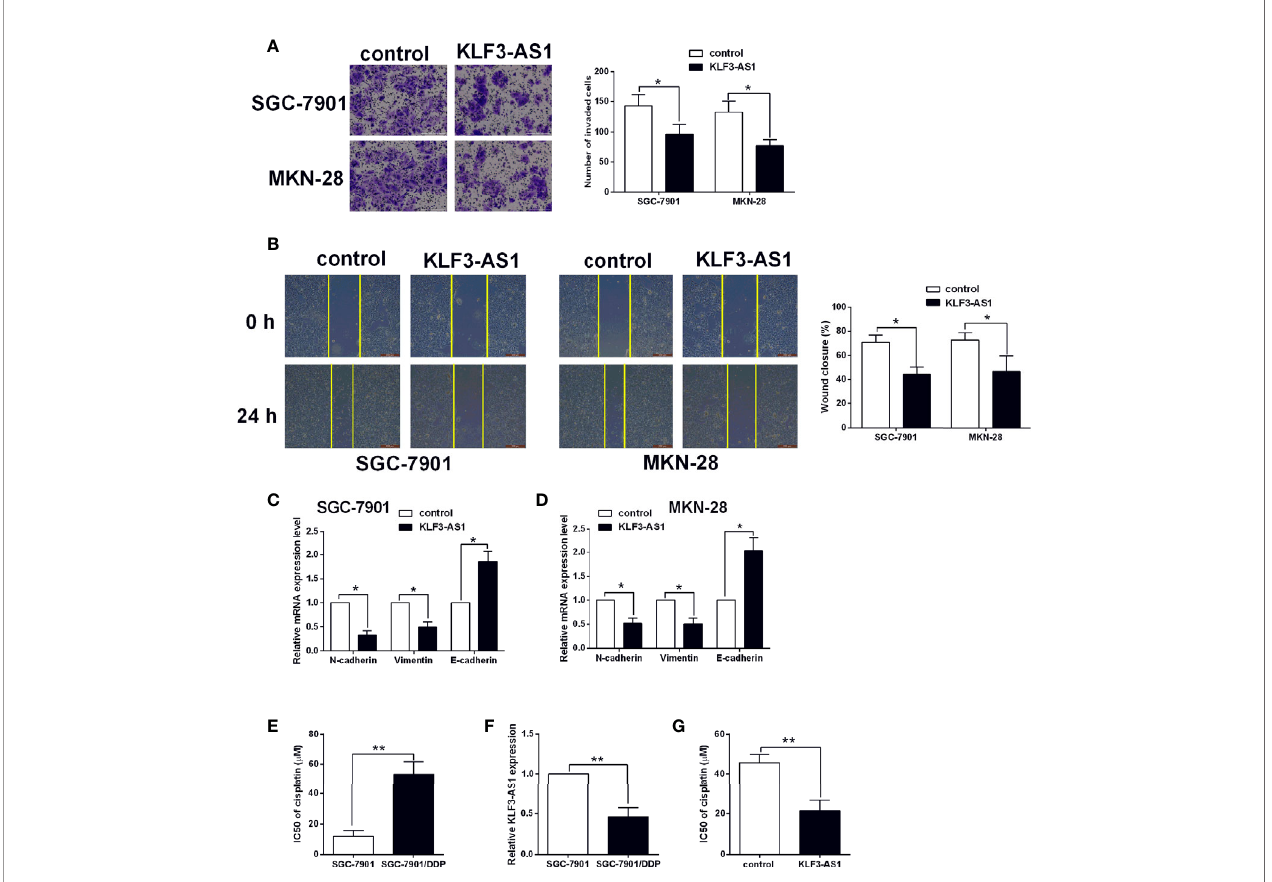
FIGURE 2 | KLF3-AS1 overexpression suppressed gastric cancer cell invasion, migration and EMT, but promoted chemosensitivity to cisplatin. The gastric cancer cells including SGC-7901 and MKN-28 were transfected with pcDNA3.1 (control group) or pcDNA3.1-KLF3-AS1 (KLF3-AS1), and at 24 h after transfection, (A) cell invasion of SGC-7901 and MKN-28 cells was determined by Transwell invasion assay; (B) cell migration of SGC-7901 and MKN-28 cells was determined by wound healing assay; (C, D) the mRNA expression levels of N-cadherin, vimentin and E-cadherin in SGC-7901 and MKN-28 cells were determined by qRT-PCR; (E) The IC50 values of cisplatin in SGC-7901 and SGC-7901/DDP cells were determined by CCK-8 assay. (F) KLF3-AS1 expression level in SGC-7901 and SGC-7901/DDP cells was determined by qRT-PCR. (G) The IC50 values of cisplatin SGC-7901/DDP cells transfected with pcDNA3.1 or pcDNA3.1-KLF3-AS1 were determined by CCK-8 assay (Student ’ s t-test). N = 3; *P < 0.05 and **P <